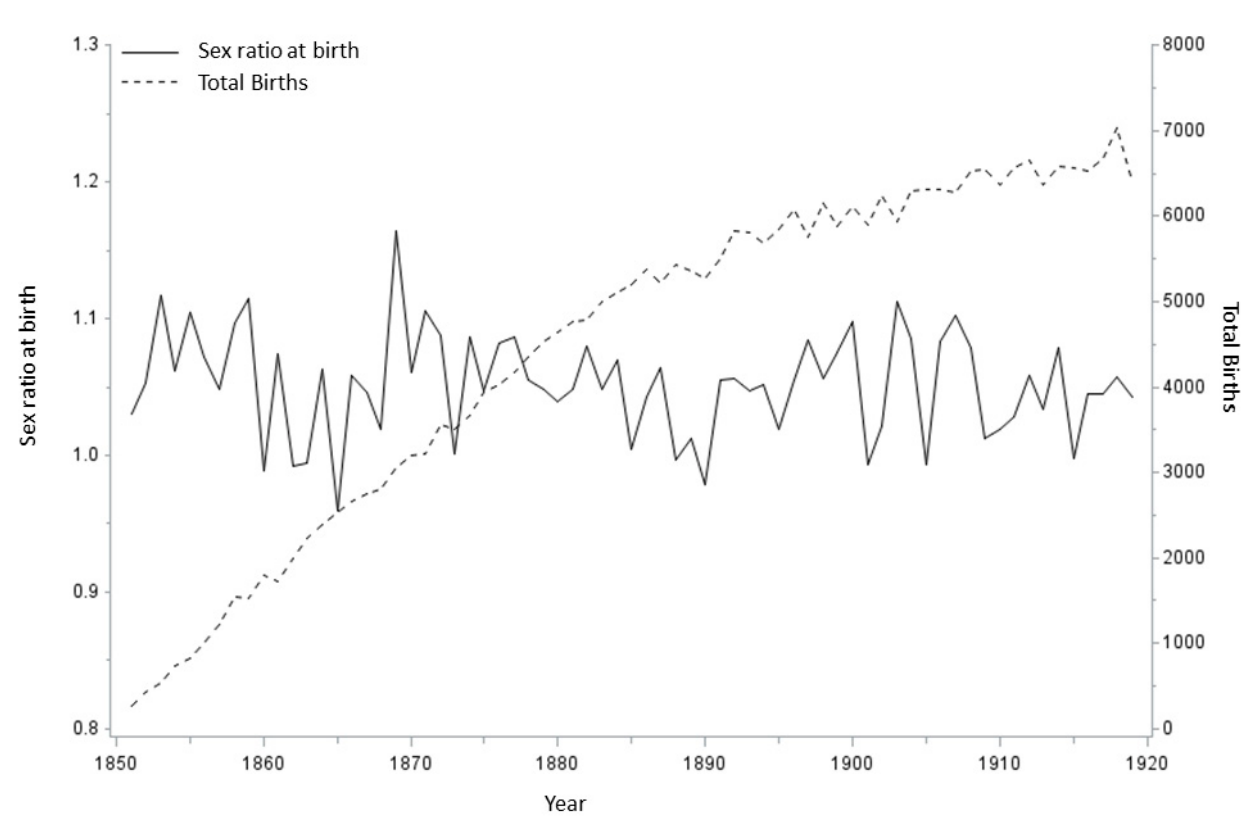
Figure 3. Sex ratio at birth and total births for other Utah counties 1851–1919.